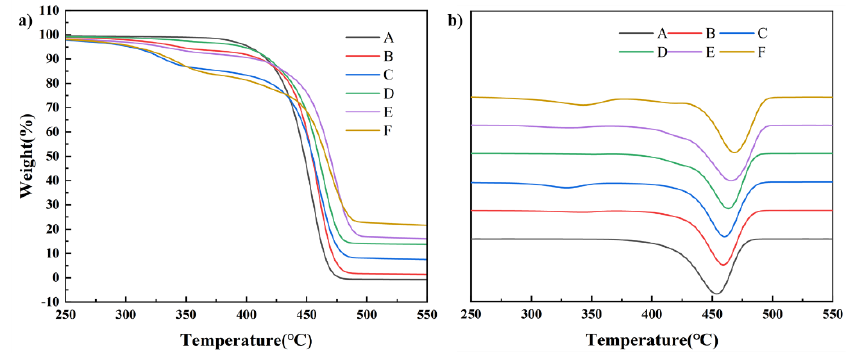
Figure 3. T he ( a ) TGA and ( b ) DTA curves of composite s. Figure 3. The ( a ) TGA and ( b ) DTA curves of composites. Table 3. The TGA data of composites. Table 3. The TGA data of composites.